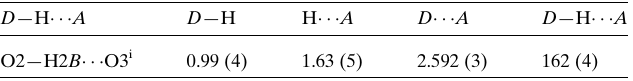
Table 1 Hydrogen-bond geometry (A˚ , (cid:3) ).